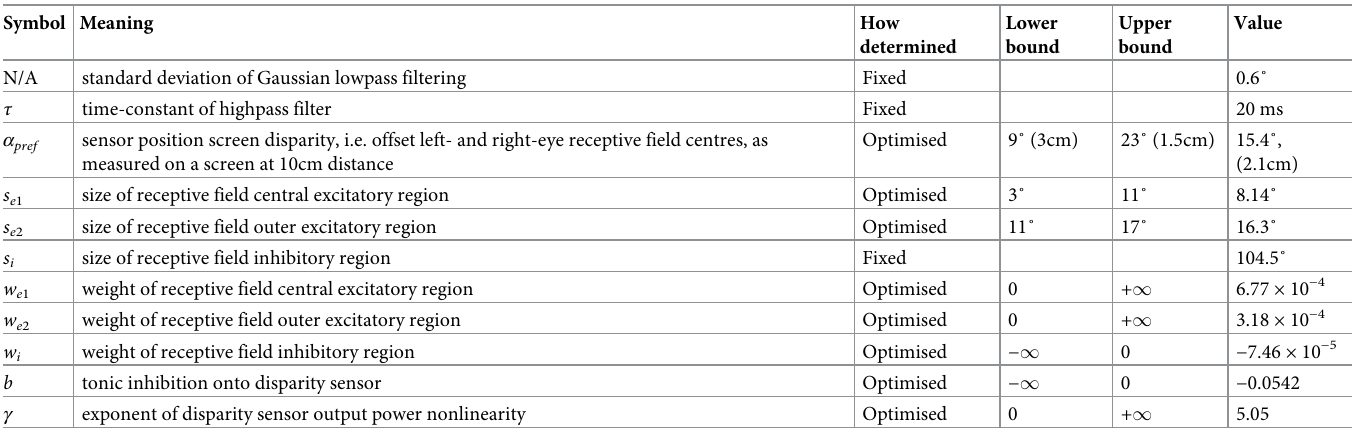
strikes elicited per trial, averaged over all N j trials; and M j ð p Þ is the expected number of trials model strikes per trial predicted by the model (Eq 3) for a stimulus at that simulated distance and size, given the current set of model parameters p . This expression is derived from the likeli- hood of observing M given a Poisson distribution with mean M , though note that L is data model not exactly equal to the log-likelihood, since for simplicity we have omitted constant terms Table 2. Parameters controlling the behaviour of our model, and how these were obtained. The top two rows are for the early visual system, and the remainder describe the disparity sensor. Parameters optimised by fitting to the data were constrained to lie between the stated bounds. The receptive field regions were squares, with the sizes s e 1 , s e 2 , s i being the side-length. s i is simply chosen to be very large compared to the stimulus. In our simulation, each pixel represents 0.154˚ visual angle. The sensor dispar- ity is given both as a screen disparity α pref , and in parentheses as the corresponding distance D pref .